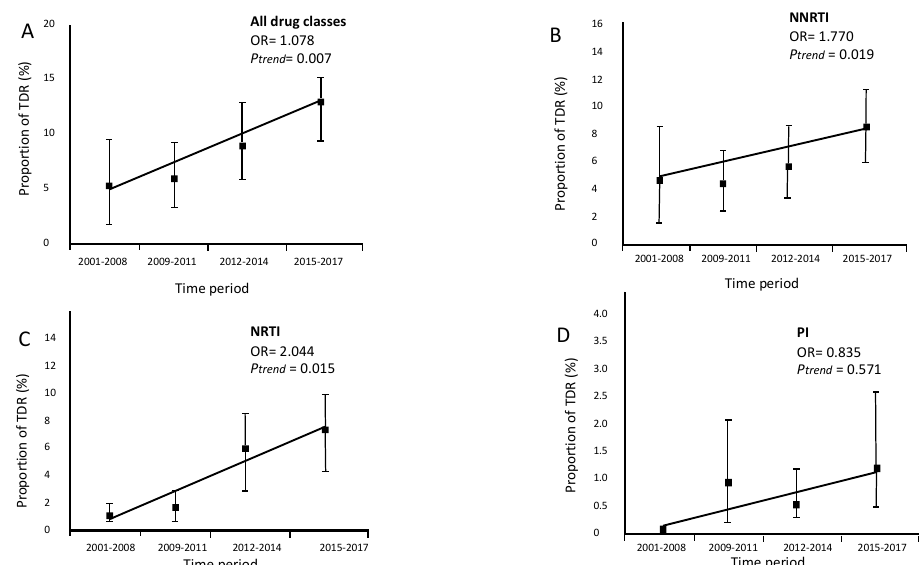
Figure 2. Trends of proportion of transmitted drug resistance (TDR) in migrants followed up in Portuguese hospitals (2001–2017). N(2001–2008) = 137, N(2009–2011) = 325, N(2012–2014) = 228, N(2015–2017) = 327. ( A )TrendforoverallTDR.( B )Trendfortransmittednucleosidereversetranscriptase inhibitor (NRTI) resistance. ( C ) Trend for transmitted NNRTI resistance. ( D ) Trend for transmitted protease inhibitors (PI) resistance.